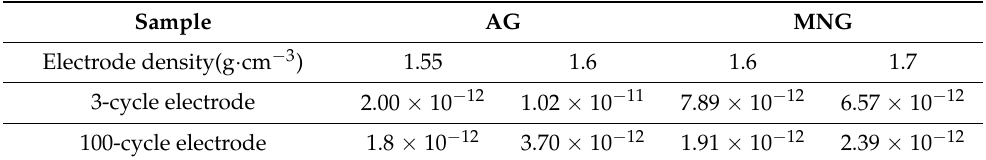
Table 3. Diffusion coefficient for AG and MNG